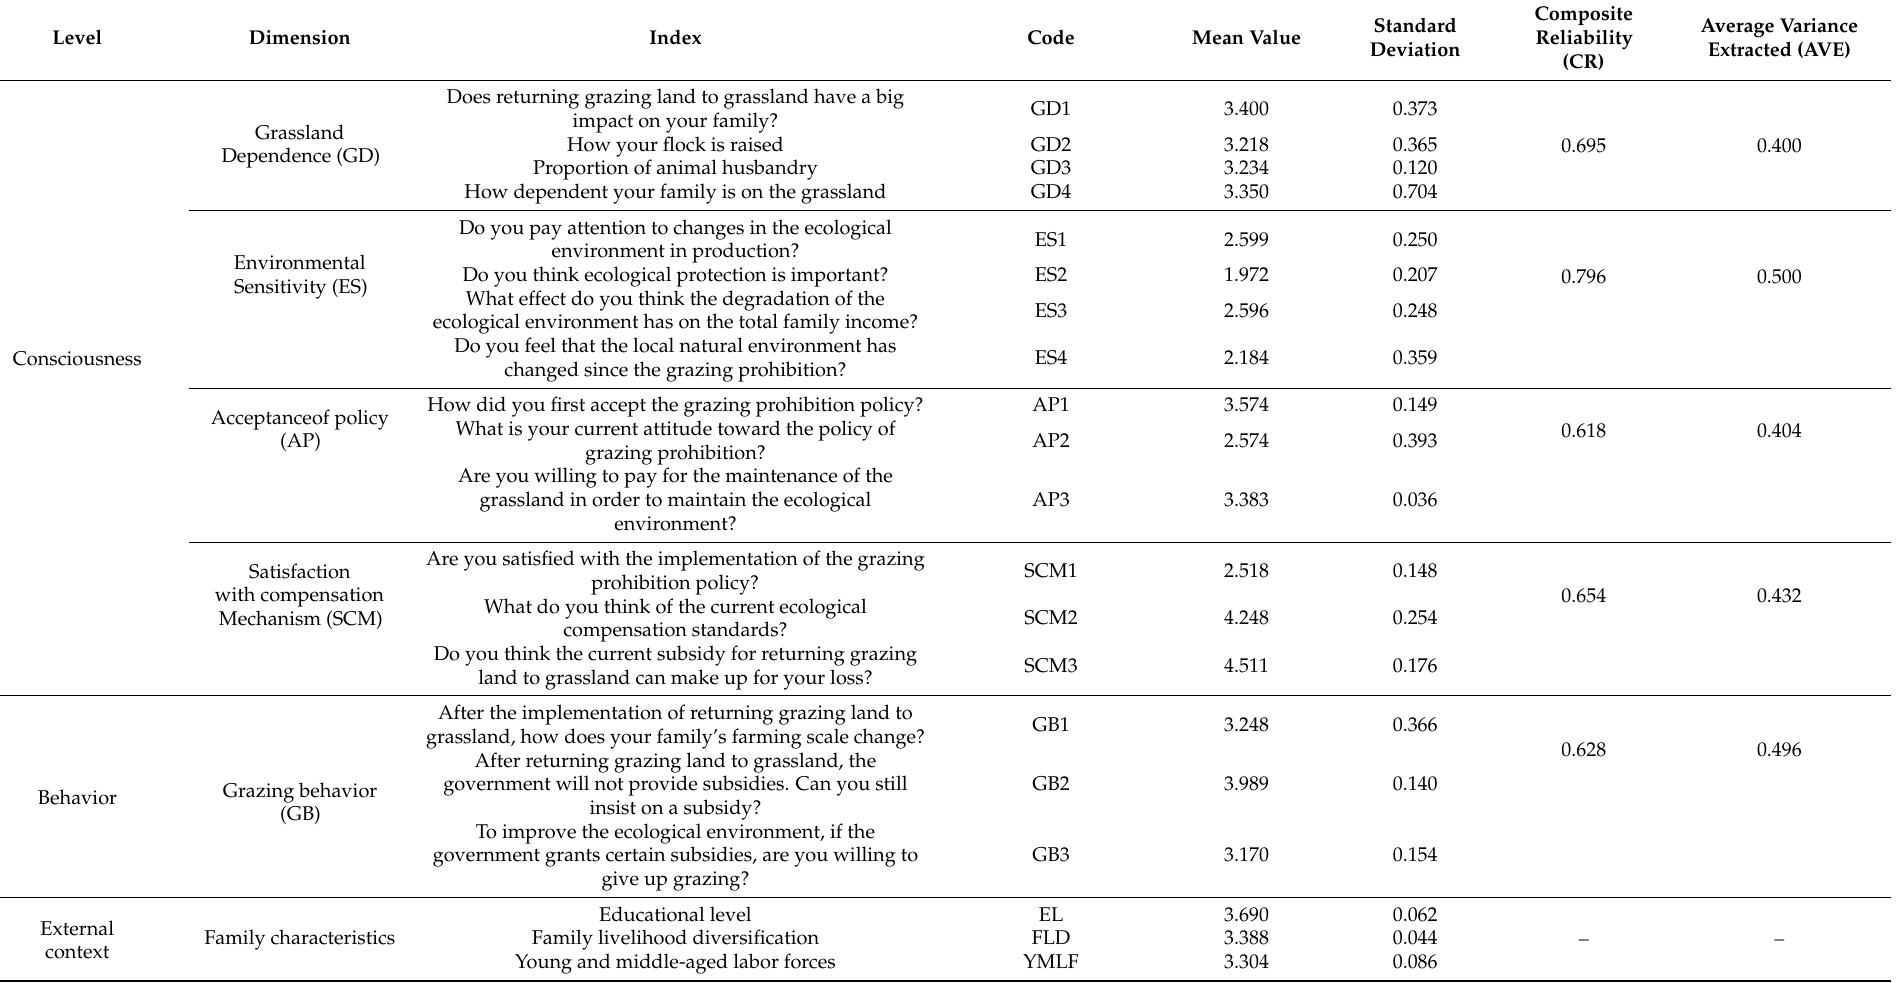
Table 1. Index system of influencing factors of grazing behavior. (Educational level (EL), Family livelihood diversification (FLD) and Young and middle-aged labor forces (YMLF) in family characteristics represent three demographic characteristics, which are not meant to represent the variable of family characteristics together. Therefore, Composite Reliability (CR) and Average Variance Extracted (AVE) values are not calculated and are represented by “_” in the